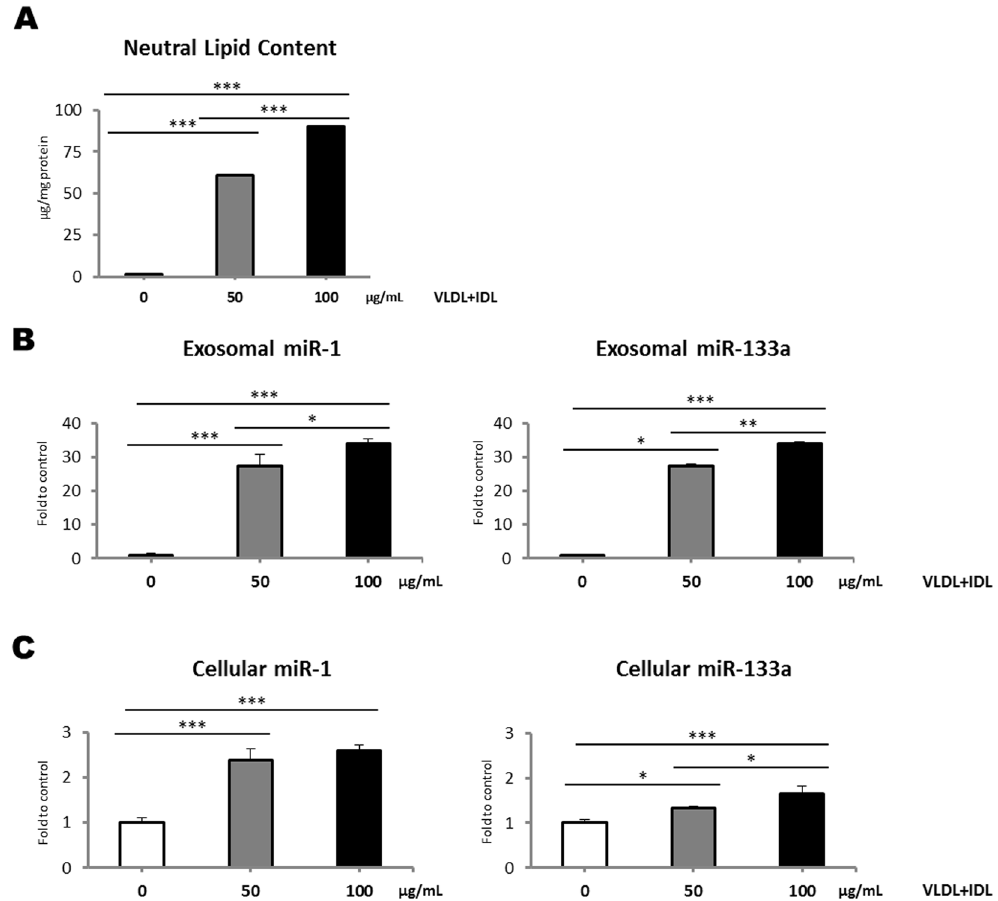
Figure 3. ( A ) Neutral lipid accumulation in HL-1 cells after exposure to VLDL + IDL. Data represent the mean ± SD. ( B ) Quantification by RT-qPCR of exosomal miR-1 and miR-133a levels after exposure to VLDL + IDL. Relative quantification was performed using cel-miR-39-3p for normalization. ( C ) Quantification by RT-qPCR of HL-1 miR-1 and miR-133a levels after exposure to VLDL + IDL. Relative quantification was performed using U6 for normalization. HL-1 cells were incubated for 24 hours in the absence or presence of VLDL + IDL (50 or 100 μ g/mL). Differences between groups were analysed using one-way ANOVA followed by Tukey’s post hoc test for comparison between each subgroup. Results are expressed as the mean + SD relative to control cells (incubated in the absence of VLDL + IDL). * P < 0.050; ** P < 0.010; *** P <